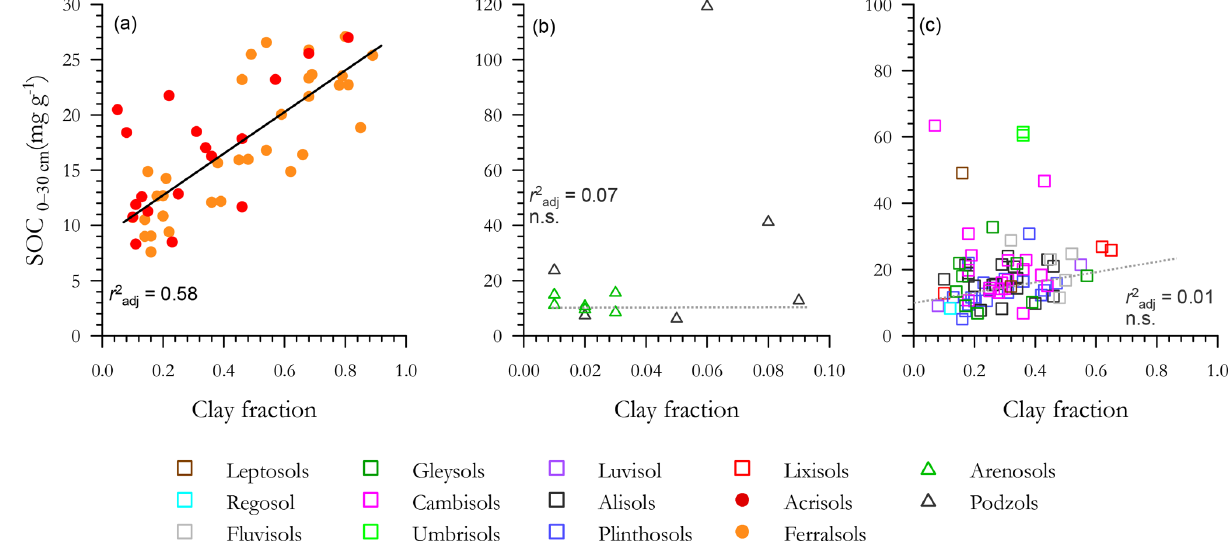
Figure 5. Associations between soil organic C and clay fraction for the three soil groups. (a) Low-activity clay (LAC), (b) arenic soils and (c) soils containing high-activity clays (HACs). Only LAC shows a significant regression. Non-significant regressions in arenic and HAC soils are shown as dotted